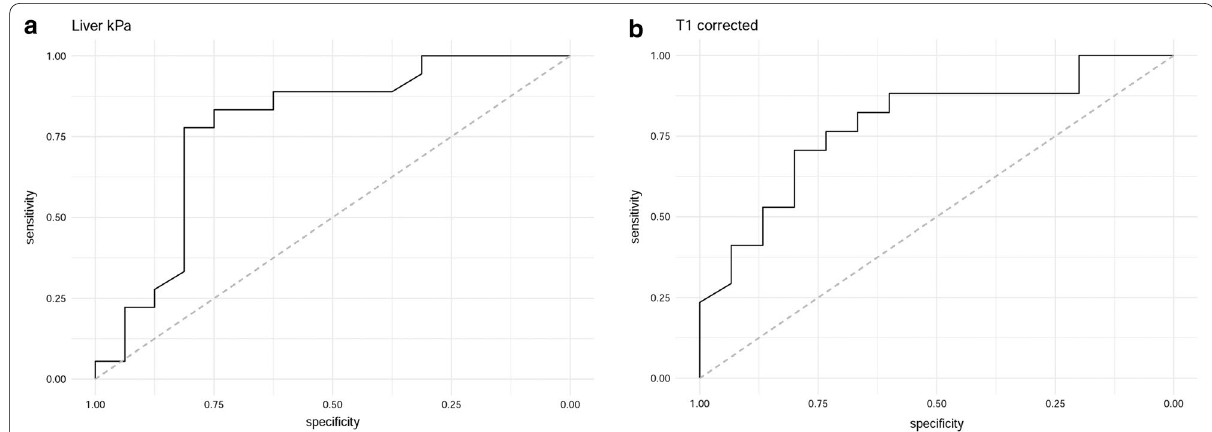
Fig. 6 ROC curve of MRE-LSM and cT1 for differentiation of patients with SOS